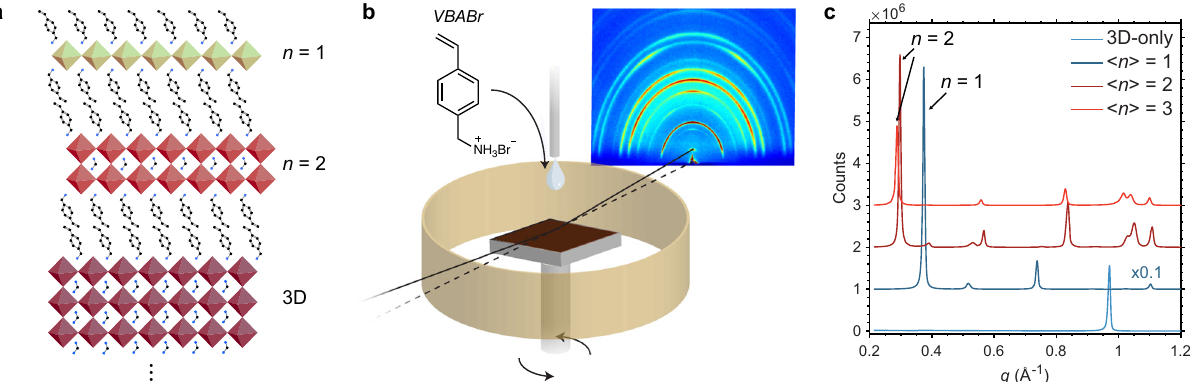
Fig. 1 Diffraction from 2D/3D perovskite structures. a Illustration of a 2D/3D interface for consecutive layers of 3D, n = 2, and n = 1 RDPs. b Schematic of the in situ GIWAXS experimental system used herein. A solvent dripper is positioned directly above the sample, which is mounted on a motorized pole with double-sided carbon tape. A Kapton shield encircles the spinning sample, prevented liquid from splashing onto the X-ray optics and the detector. VBABr: vinylbenzylammonium bromide. c Ex situ XRD patterns of RDP thin fi lms with central n values of 1 – 3, and 3D control. Patterns are offset for clarity. Note: these are not 2D/3D perovskite thin fi lms, and were synthesized from solutions containing precursor ratios corresponding to each n